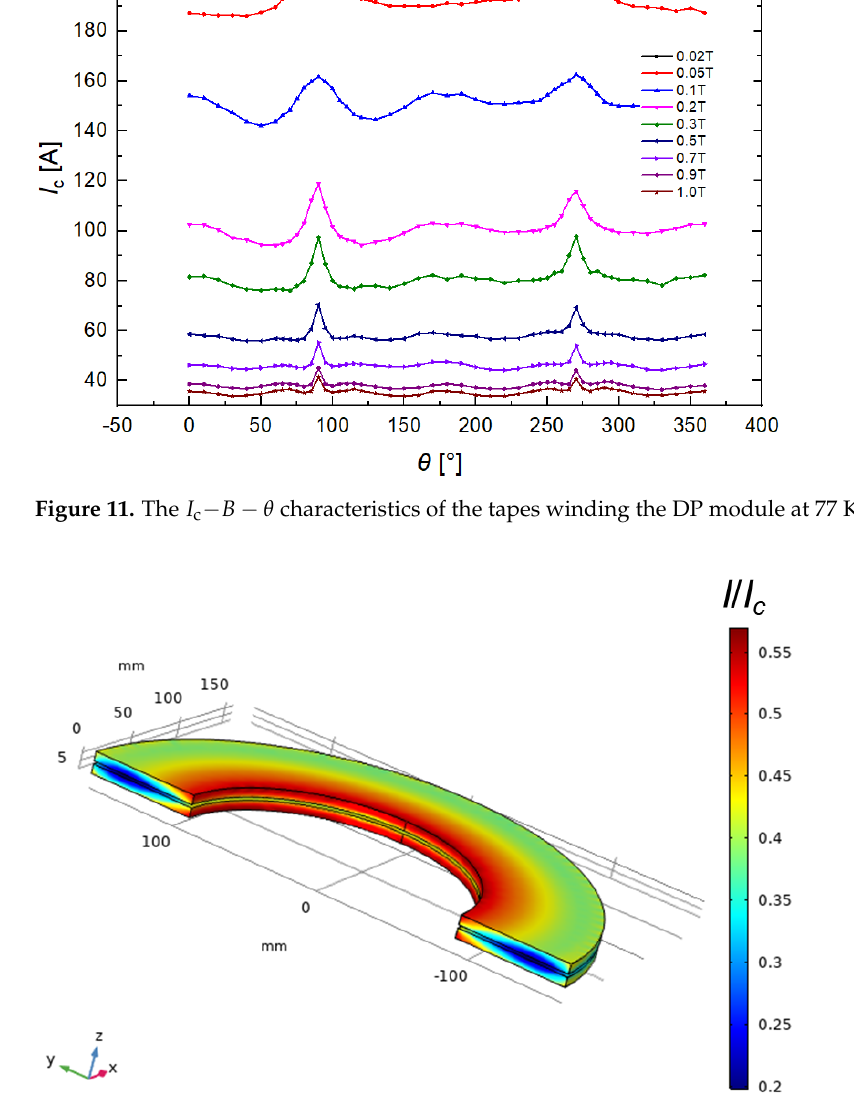
Figure 12. Load factor distribution on the arc edge of the DP Module at 77